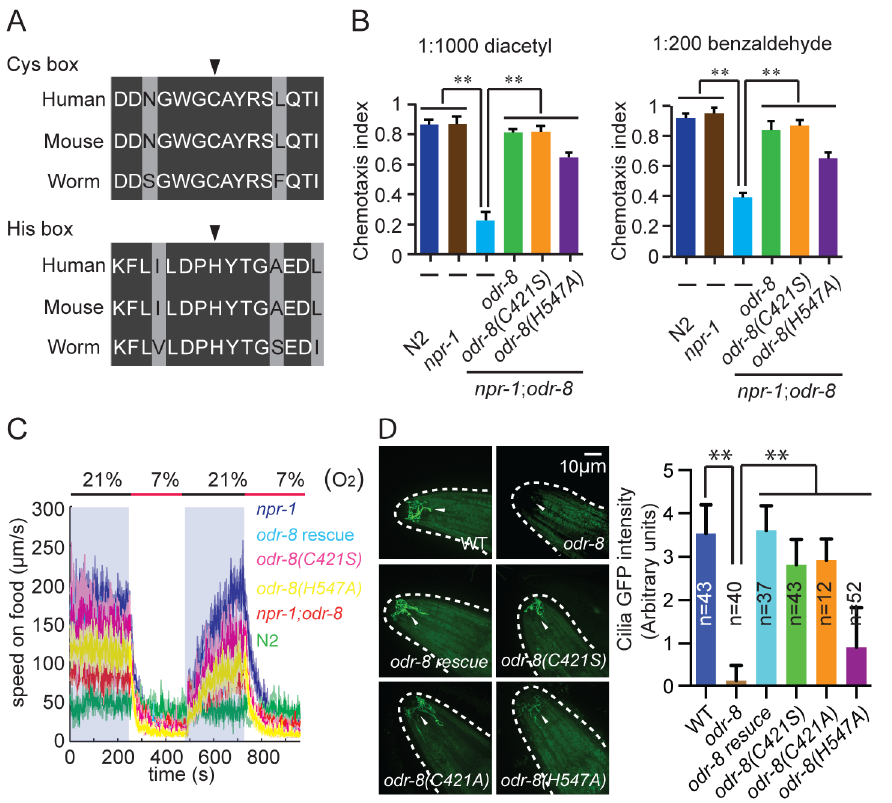
Figure 7. Non-catalytic action of ODR-8 Ufm1-specific protease 2. (A) Conservation of Cysteine and Histidine boxes in UfSP2 from worm, mouse and man. The catalytic cysteine and histidine residues are marked by an arrowhead. (B–D) odr-8 transgenes in which the catalytic cysteine or histidine residues are mutated retain the ability to rescue odr-8(ky31) mutant phenotypes for odorant responses to diacetyl and benzaldehyde (B), oxygen responses (C) and biogenesis and localization of ODR-10 GPCR in AWA neurons (D). In D, ODR-10 localization in AWA cilia was scored using a scale from 0 to 4, where 0 reflects no observable localization and 4 reflects strong ODR-10 accumulation. Representative images for each genotype are shown. The odr-8 allele rescued in these assays was odr-8(ky31) . ** indicates p , 0.01 (ANOVA, Bonferroni’s multiple comparisons test).